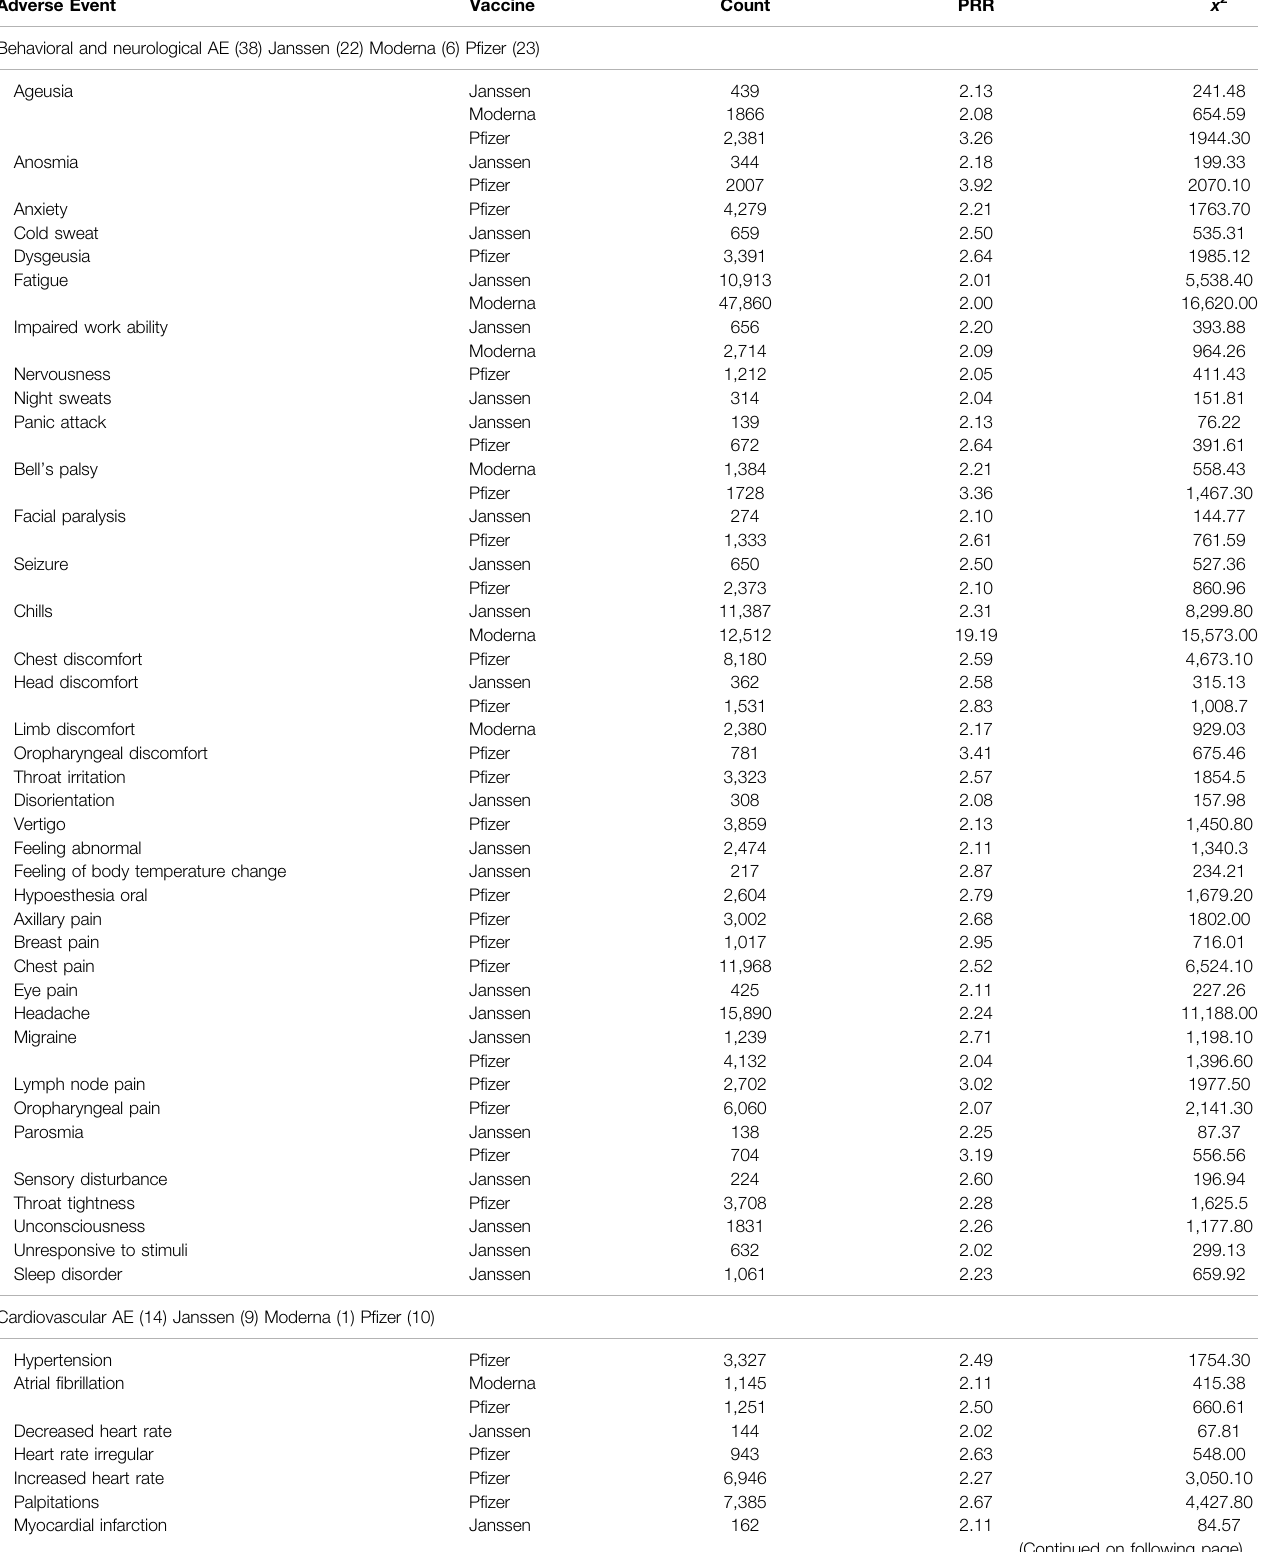
TABLE 3 | Statistically signi fi cant medically relevant AEs associated with the Janssen, Moderna, and P fi zer COVID-19 vaccines. Adverse Event Vaccine Count PRR x